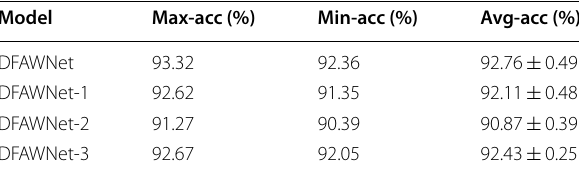
Table 6 Experimental results of the ablation